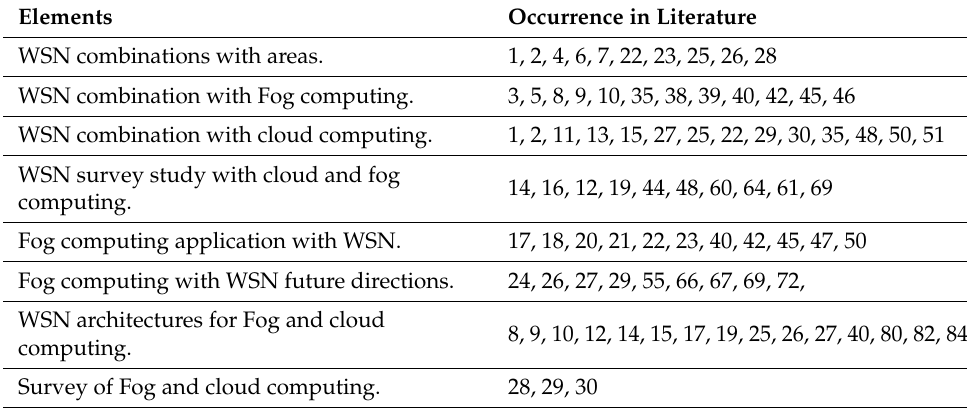
Table 3. Occurrence of factors in the literature.